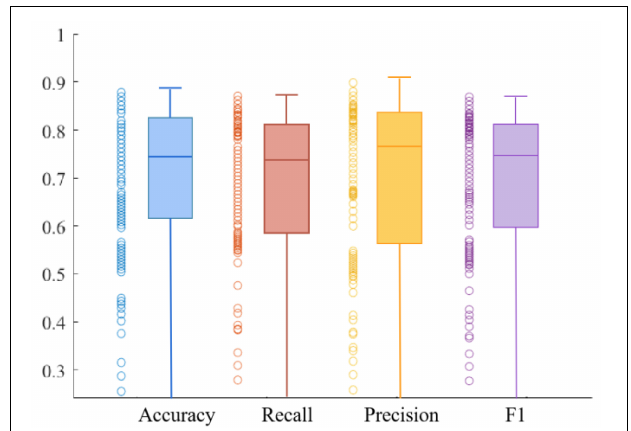
FIGURE 10 | Combination of scatter plot and box plot of training set.